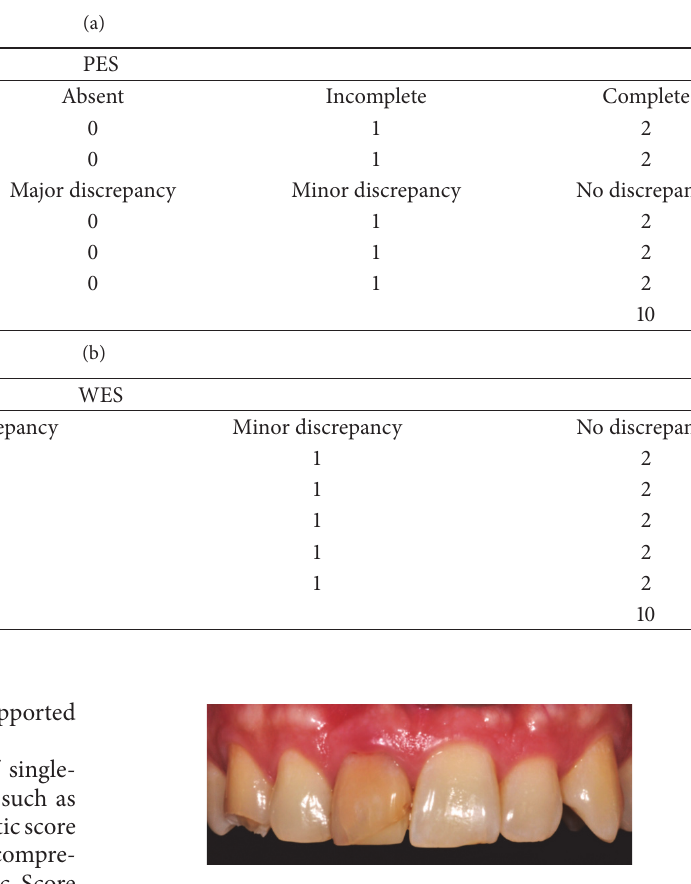
Table 1: Detailed description of PES/WES.